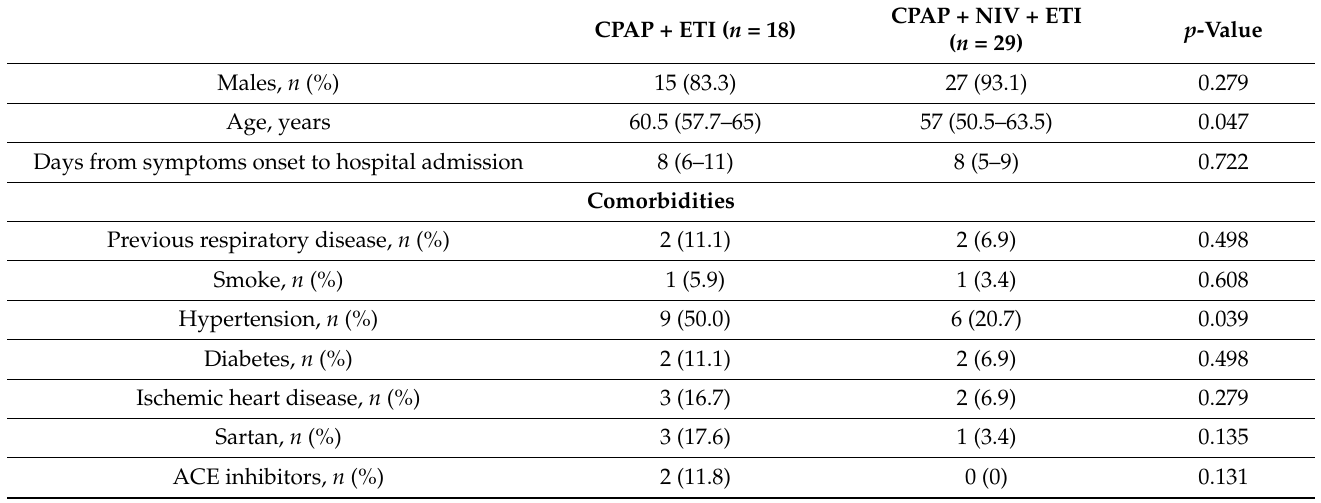
Table 4. Characteristics at admission and at failure time of patients that failed CPAP + NIV treatment and were intubated vs. patients that succeeded CPAP +